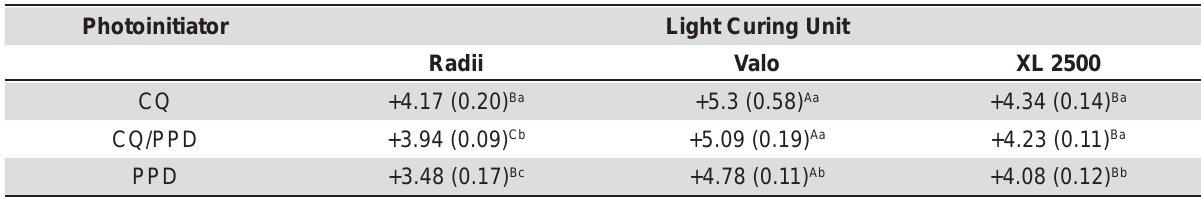
Table 5- Mean Y value and standard deviation (±) provided for each of the photoinitiator Photoinitiator